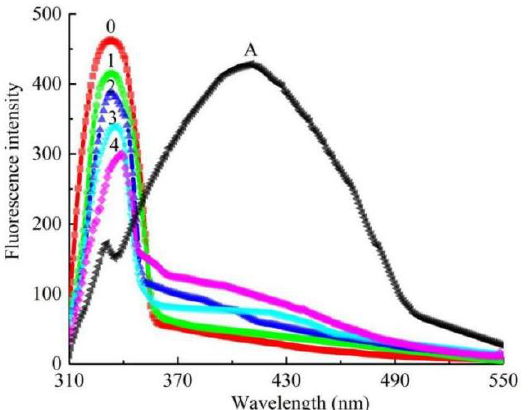
Figure 4. Fluorescence emission spectra of mushroom tyrosinase solution in presence of Q1 with different concentrations. Curves 0 – 4 representing concentrations of Q1 are 0, 9, 18, 27, 36 μM; curve A is fluorescence emission spectra of Q1 at concentration of 36 μM.